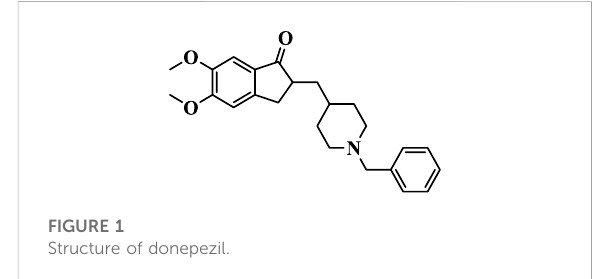
FIGURE 1 Structure of